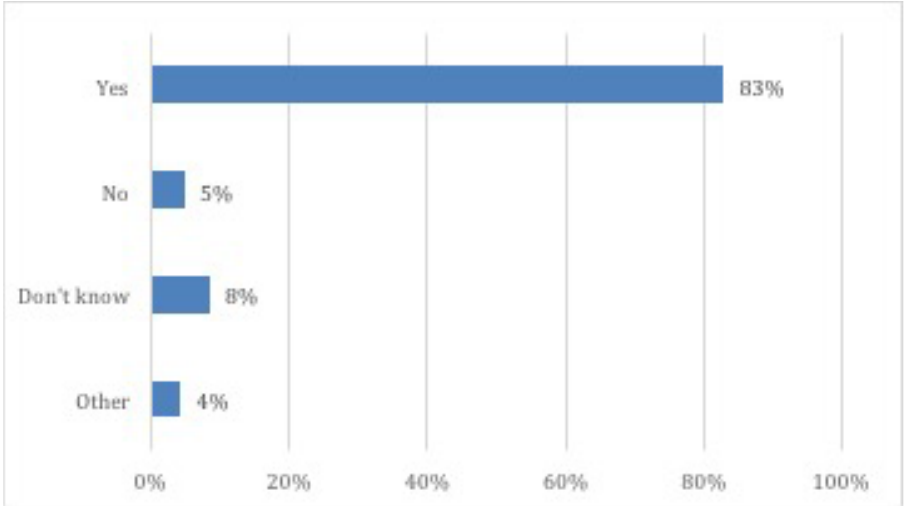
Figure 8: Results of the ‘2015 Danish detectorists survey’. Detectorists were asked to agree or disagree to the statement that it is important that finds and contextual data are accessible for archaeologists and researchers.